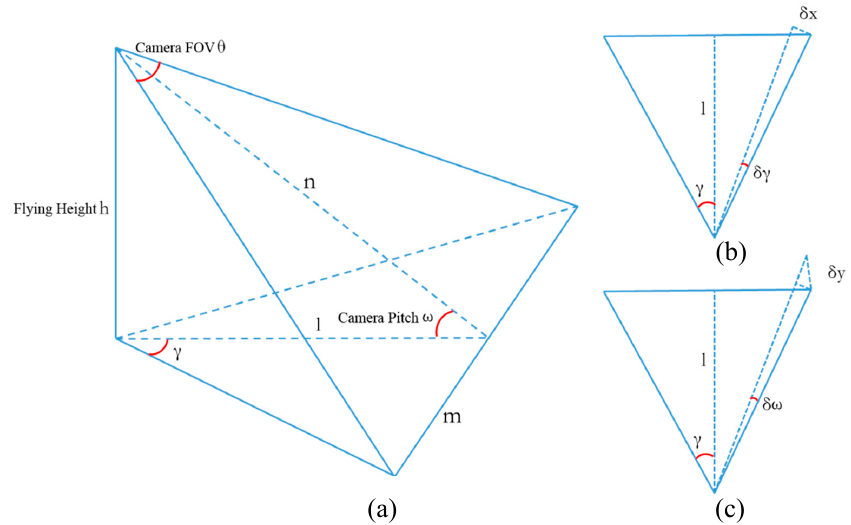
Figure 10. Localization error caused by roll, pitch, and yaw error. ( a ) The relationship between the horizontal FOV of the camera θ , the pitch angle of the camera ω , the height of the UAV h , and other variables. ( b ) The target localization error δ x caused by the roll and yaw error δγ . ( c ) the target localization error δy caused by the pitch angle error.